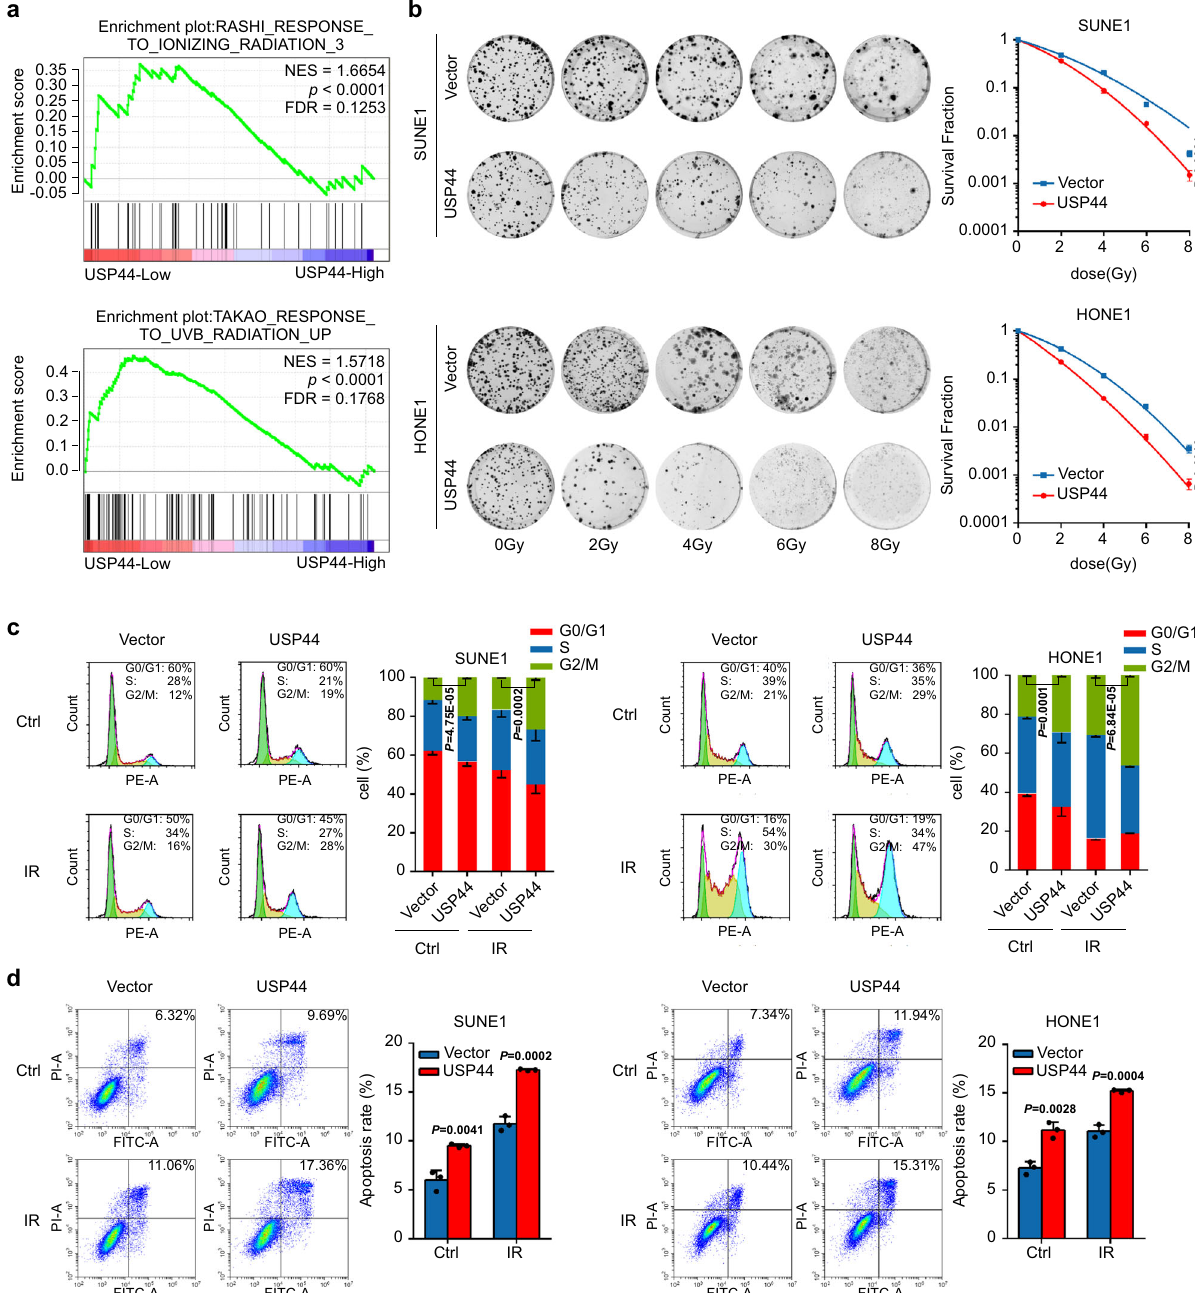
Fig. 2 USP44 enhances the radiosensitivity of NPC cells in vitro. a In the GSEA of GSE12452 gene expression data, ionising radiation